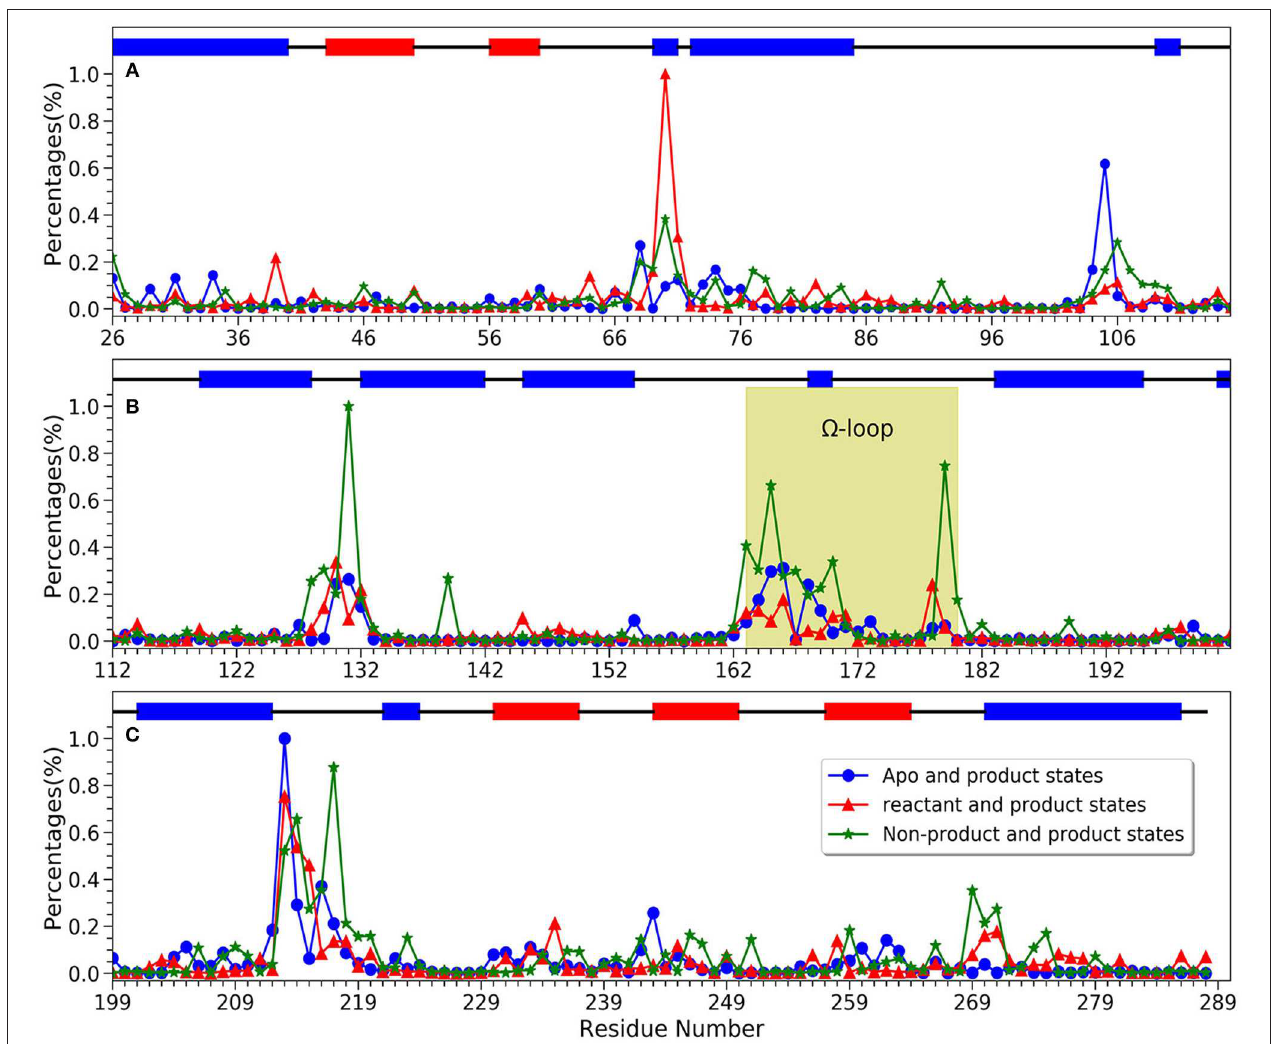
FIGURE 8 | The accumulative feature importance of each residue in TEM-1. The blue circles represent the apo and product states classification model, the red triangles represent the reactant and product states classification model, and the green stars represent the non-product and product states classification model. On the top of each sub-figure, the β -sheets and α -helices are labeled as red and blue rectangles, respectively. (cid:127) -loop is highlighted in yellow. (A) Residues 26 through 115; (B) Residues 112 through 202; (C) Residues 199 through